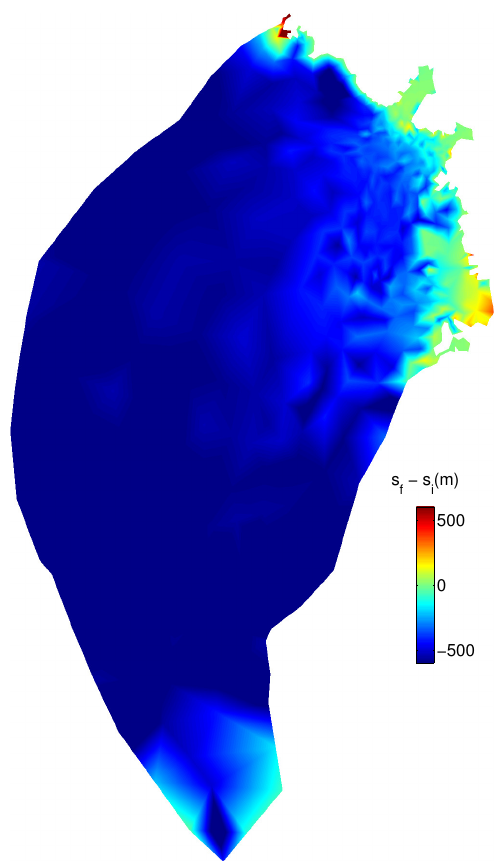
Figure 4. Difference s f – s i (in meters) between the spun-up surface height ( s f ) and the reference height for the altimetry data, taken to be the Howat et al. (2014) surface DEM in 2006 ( s i ). This spatially variable time-mean bias is removed from the observations to reach a better adequation between the model spin-up and the altimetry data used in the inversion.